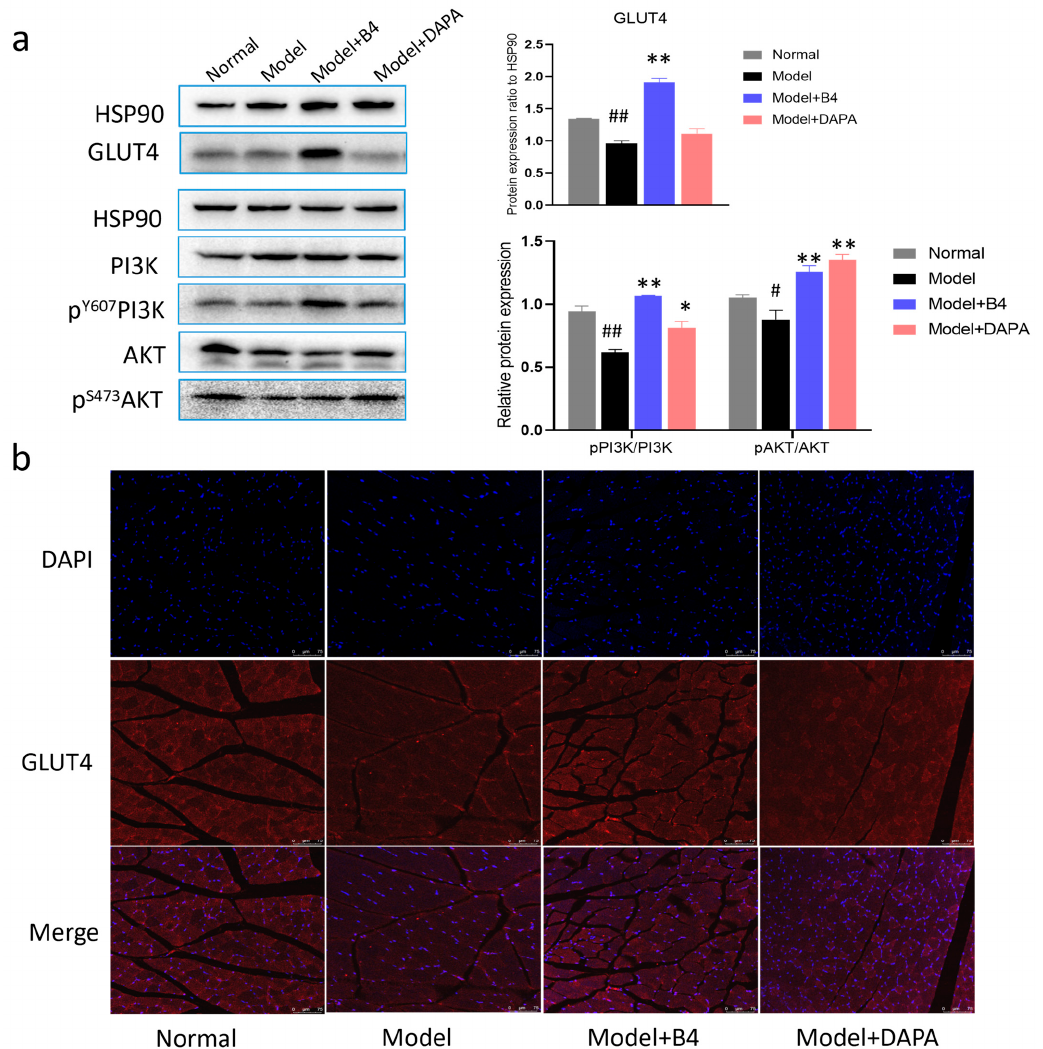
Figure 3. The expression of GLUT4 and phosphorylation of PI3K and AKT in skeletal muscle. ( a ) Protein expression; ( b ) Representative confocal microscopy images of GLUT4. Scale bar 75µm, Bule- DAPI, red-GLUT4. # p < 0.05, ## p < 0.01 vs. Normal group; * p < 0.05, ** p < 0.01 vs. Model group.